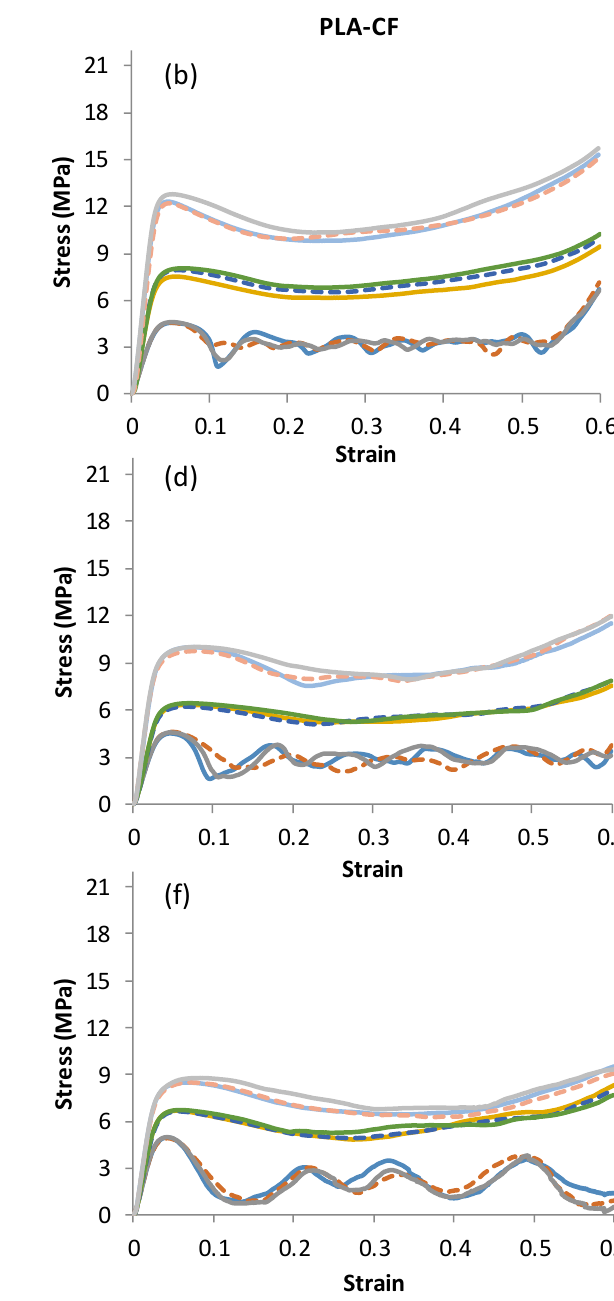
Figure 9. Stress – strain curves until 60% strain of Primitive, Gyroid, and Diamond structures at 30% RD: ( a , b ) 6 mm cell size, ( c , d ) 8 mm cell size, and ( e , f ) 12mm cell size.